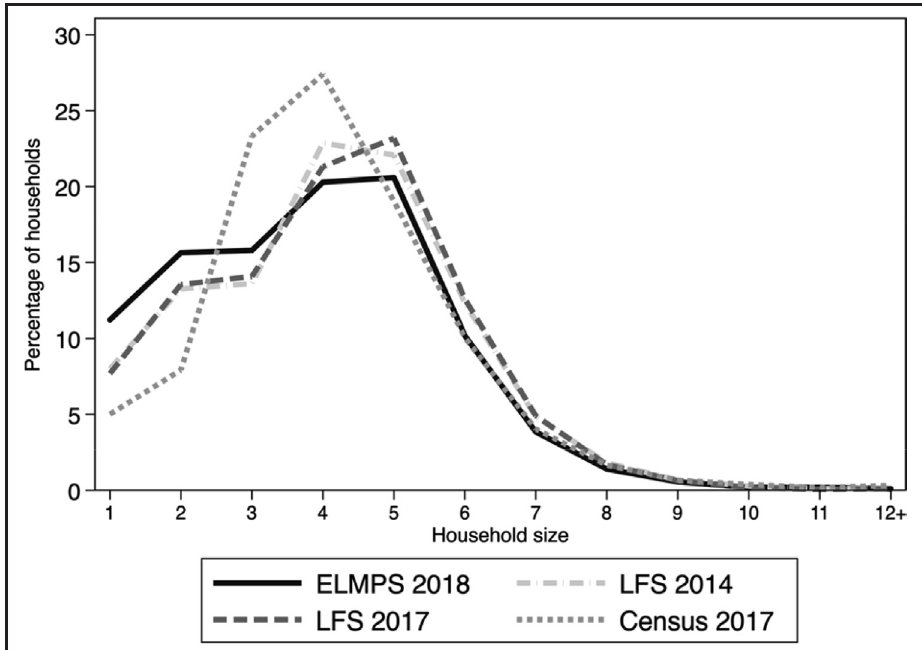
Figure 3 Comparison of household size (percentage of households), by data